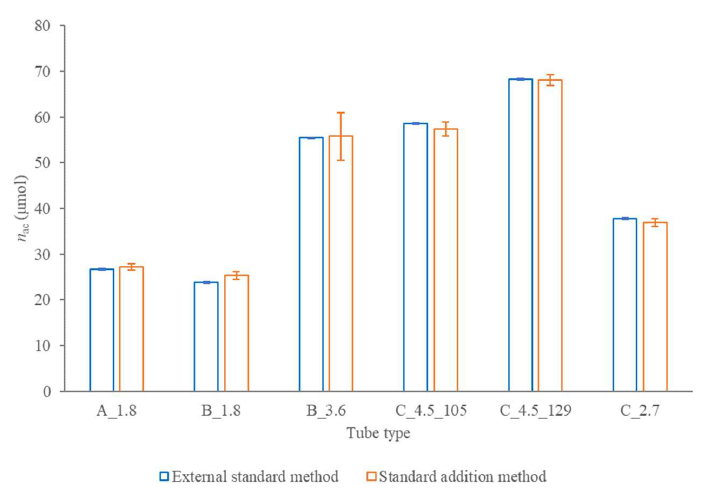
Figure 3. Anticoagulant amount per tube with 95% confidence interval determined in composite samples with the external standards (blue columns) and standard additions (orange columns) calibration method.